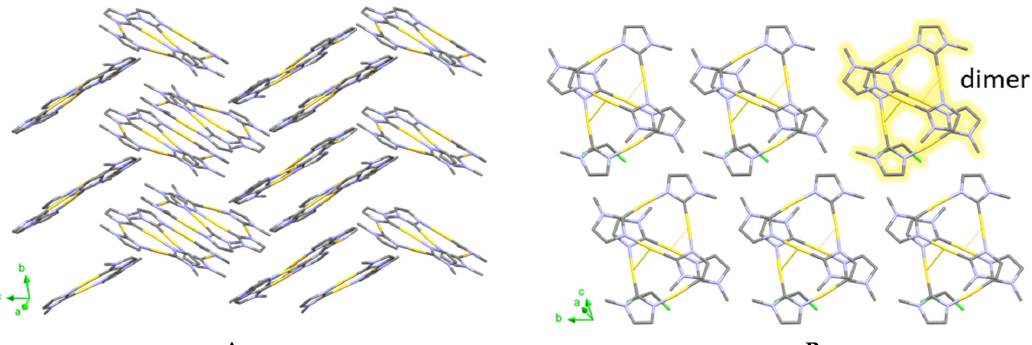
Figure 3. Packing of the different polymorphs of Au 3 (MeIm) 3 in the solid-state: ( A ) Solvent-free polymorph α . ( B ) Solvatomorph β (dichloromethane solvate). Hydrogen atoms were omitted for clarity.